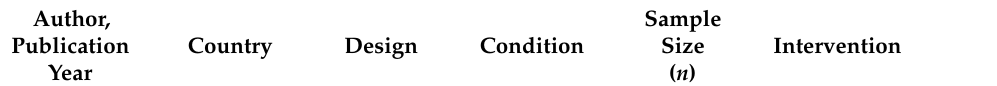
Table 2. Characteristics of included studies ( n =